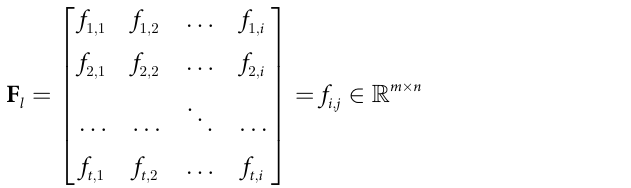
Fig 1. Hand joints. Thumb, index, middle, ring, and pinky are numbered from 1 to 5 respectively. EF position, M ( i = 1–5): finger and thumb metacarpophalangeal joint, P i finger distal interphalangeal joints. EL: elbow joint (not represented here), WR: wrist joint, RS: radial styloid, US: ulnar styloid, PALM: palm